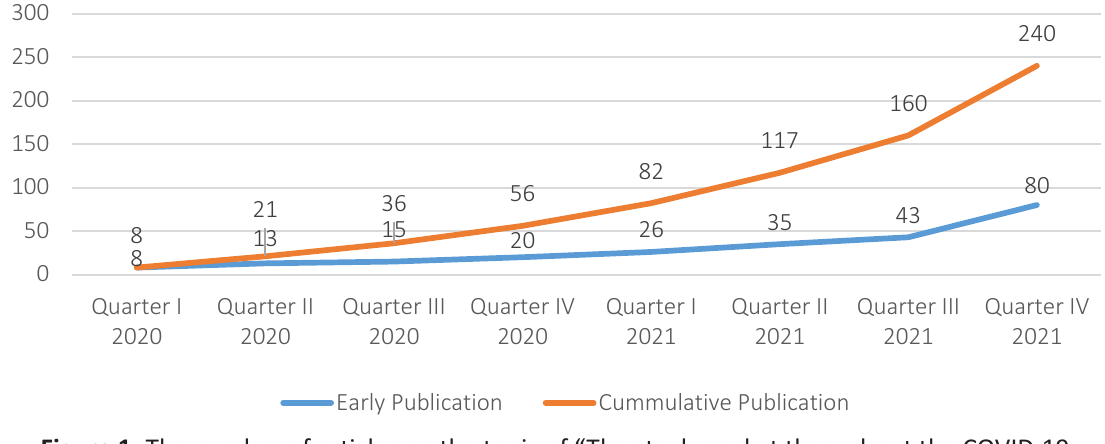
Figure 1. The number of articles on the topic of “The stock market throughout the COVID-19 pandemic” published in Scopus indexed journals from 2020 to